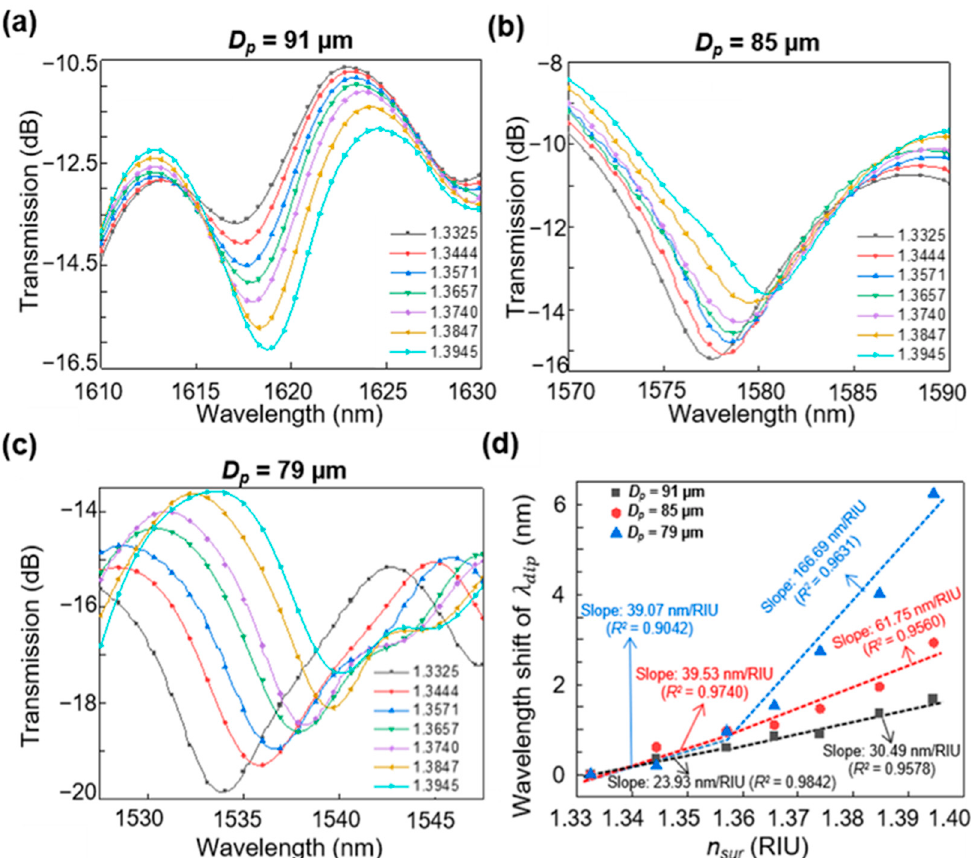
Figure 3. Calculated transmission spectrum evolution of the proposed sensor with D p values of ( a ) 91, ( b ) 85, and ( c ) 79 µ m when 1.3325 < n sur < 1.3945. ( d ) Wavelength shifts of λ dip in response to n sur for D p = 91, 85, and 79 μ m.